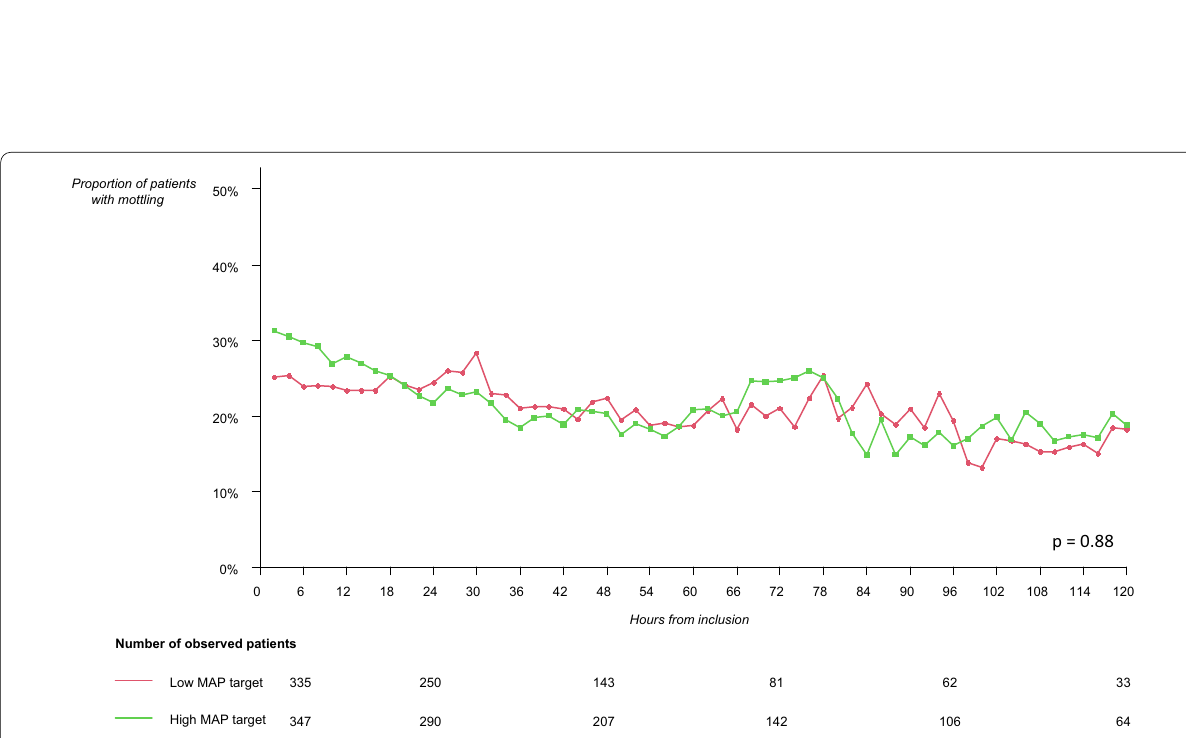
Fig. 2 Evolution of the proportion of patients with mottling according to the mean arterial pressure (MAP) target during septic shock. Low‑MAP target group: 65–70 mmHg, high‑MAP target group: 80–85 mmHg. This figure represents the proportion of patients with mottling (number of patients with mottling out of the number of patients observed) at each time. There was no difference in the evolution of proportion of patients with mottling during septic shock according to the MAP target (Wilcoxon test: p =